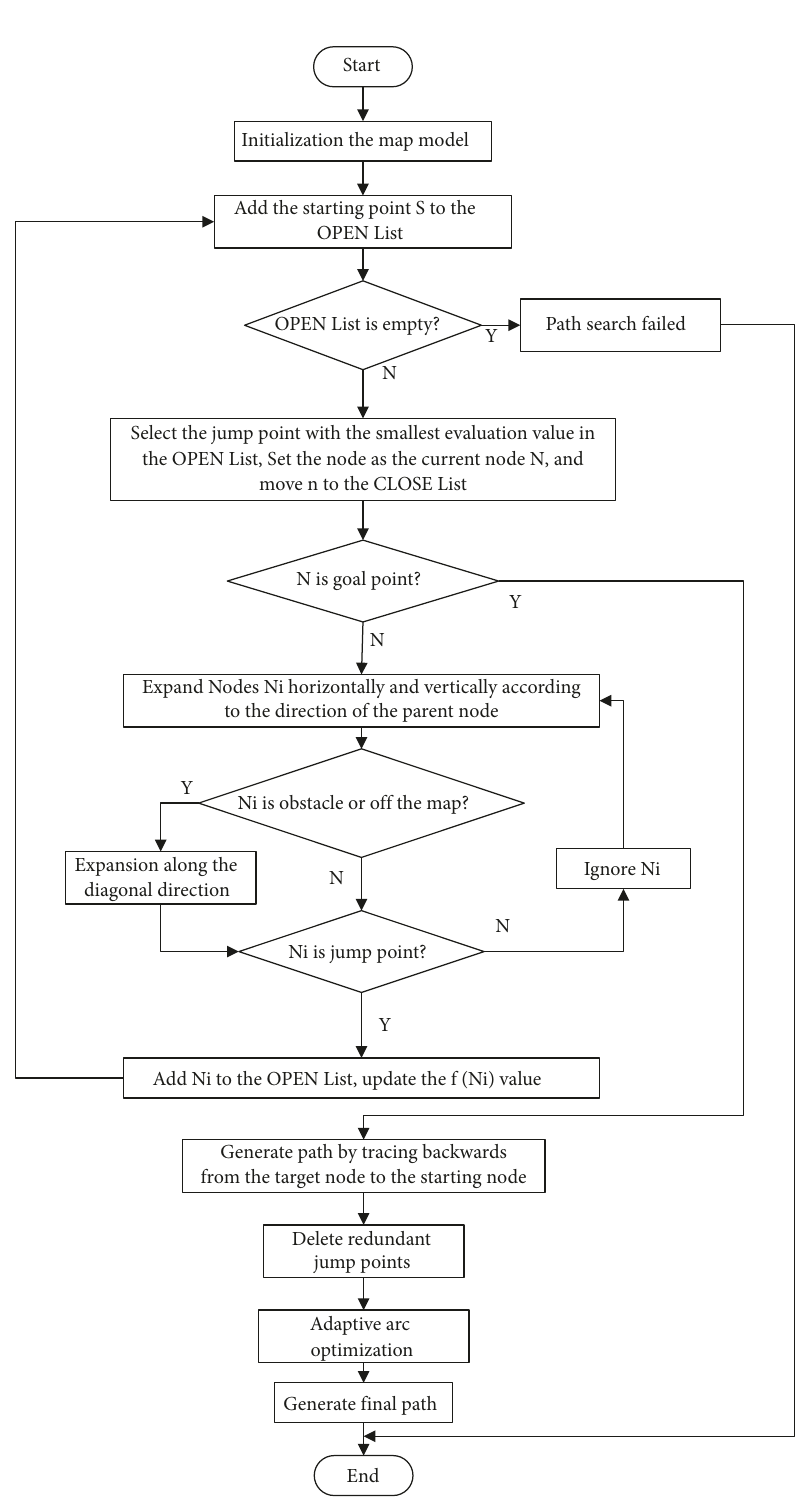
Figure 10: Flow chart of the improvement